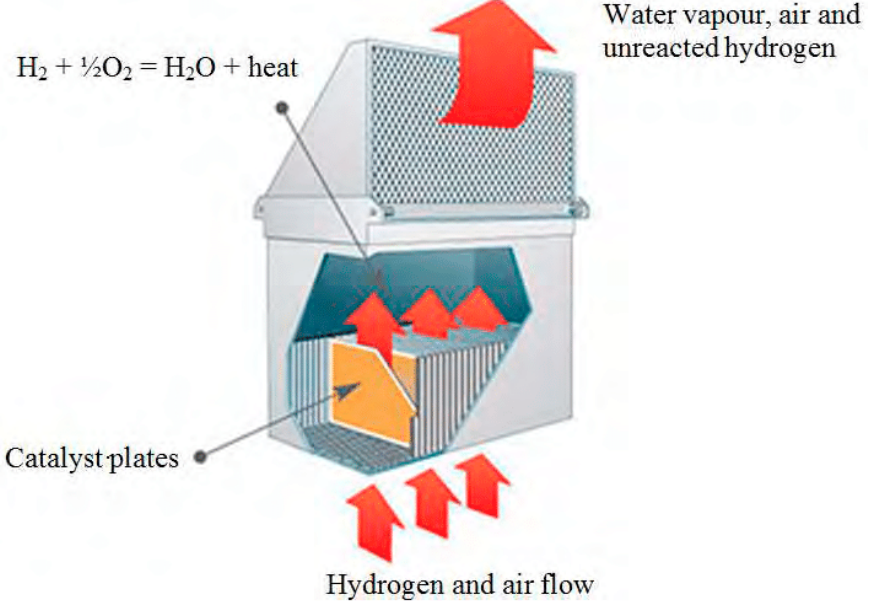
Figure 18. Schematic of a typical passive autocatalytic recombiner (PAR) design (reproduced from [182]).